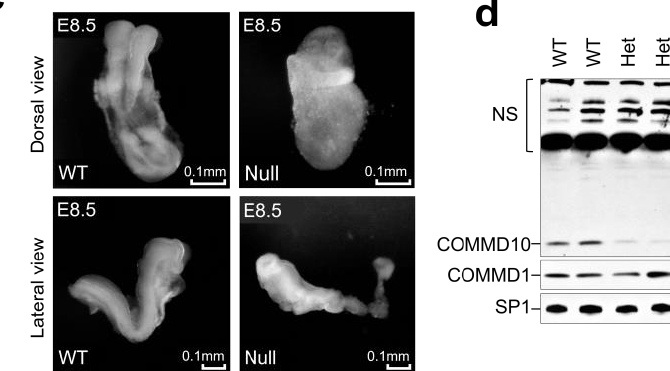
Figure 1. COMMD10 deficiency results in embryonic lethality. ( a ) Schematic drawing (up-to-scale) of the Commd10 gene on mouse chromosome 18 shown as a thick grey line. Its direction of transcription is indicated by the black arrow above. Coding exons are represented as thin black boxes. Noncoding 5′ - and 3′ -untranslated regions are shown as open boxes. The Vav-iCre cassette sketch is shown above the track. The sequence around the Vav-iCre cassette insertion site is shown below the gene scheme in an inset window. Flanking the cassette, GC nucleotides are marked by red bold underlined font and indicated by blue arrows. Their exact positions in the genome are designated by numbers from Reference GRCm39 C57BL/6J below the sequence window. ( b ) Genotyping analysis of offspring of heterozygous Commd10 Het mice (Het) mating. Commd10 Null (Null) mice had never been born but embryo genotypes show the expected Mendelian distribution. (dpc): days post-coitus. ( c ) Morphological analysis of WT and Commd10 Null (Null) embryos at E8.5 in dorsal (top panels) and lateral (bottom panels) views. ( d ) Western blot analysis of whole embryo lysates and anti-COMMD10 or anti-COMMD1 antibodies, as indicated. Anti-SP1 antibody was used as the loading control. NS: non-specific bands.